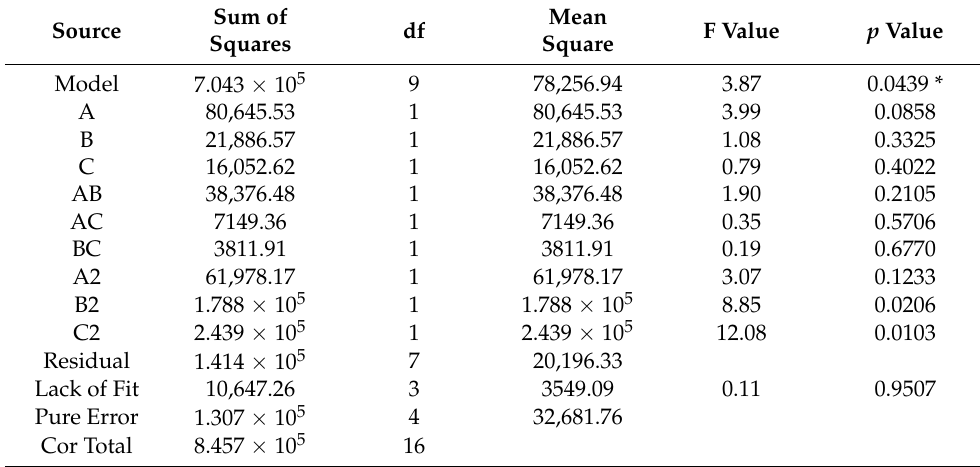
Table 5. Analysis of variance of response surface quadratic model for GA4